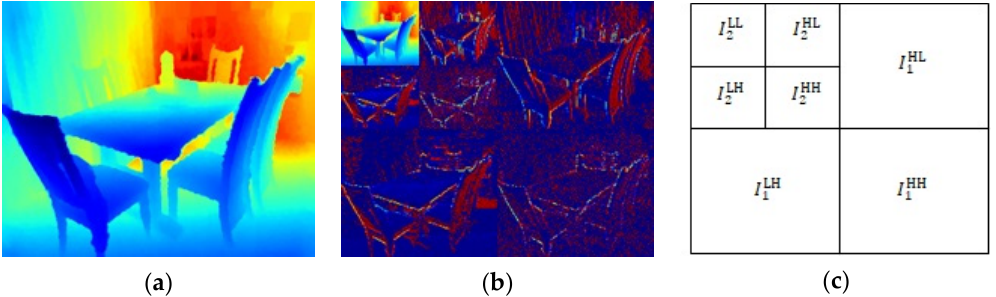
Figure 5. Discrete wavelet transform (DWT) process for depth maps, with two iterations for example: ( a ) original depth map, ( b ) depth map after 2 DWT iterations, and ( c ) labels for different image patches.